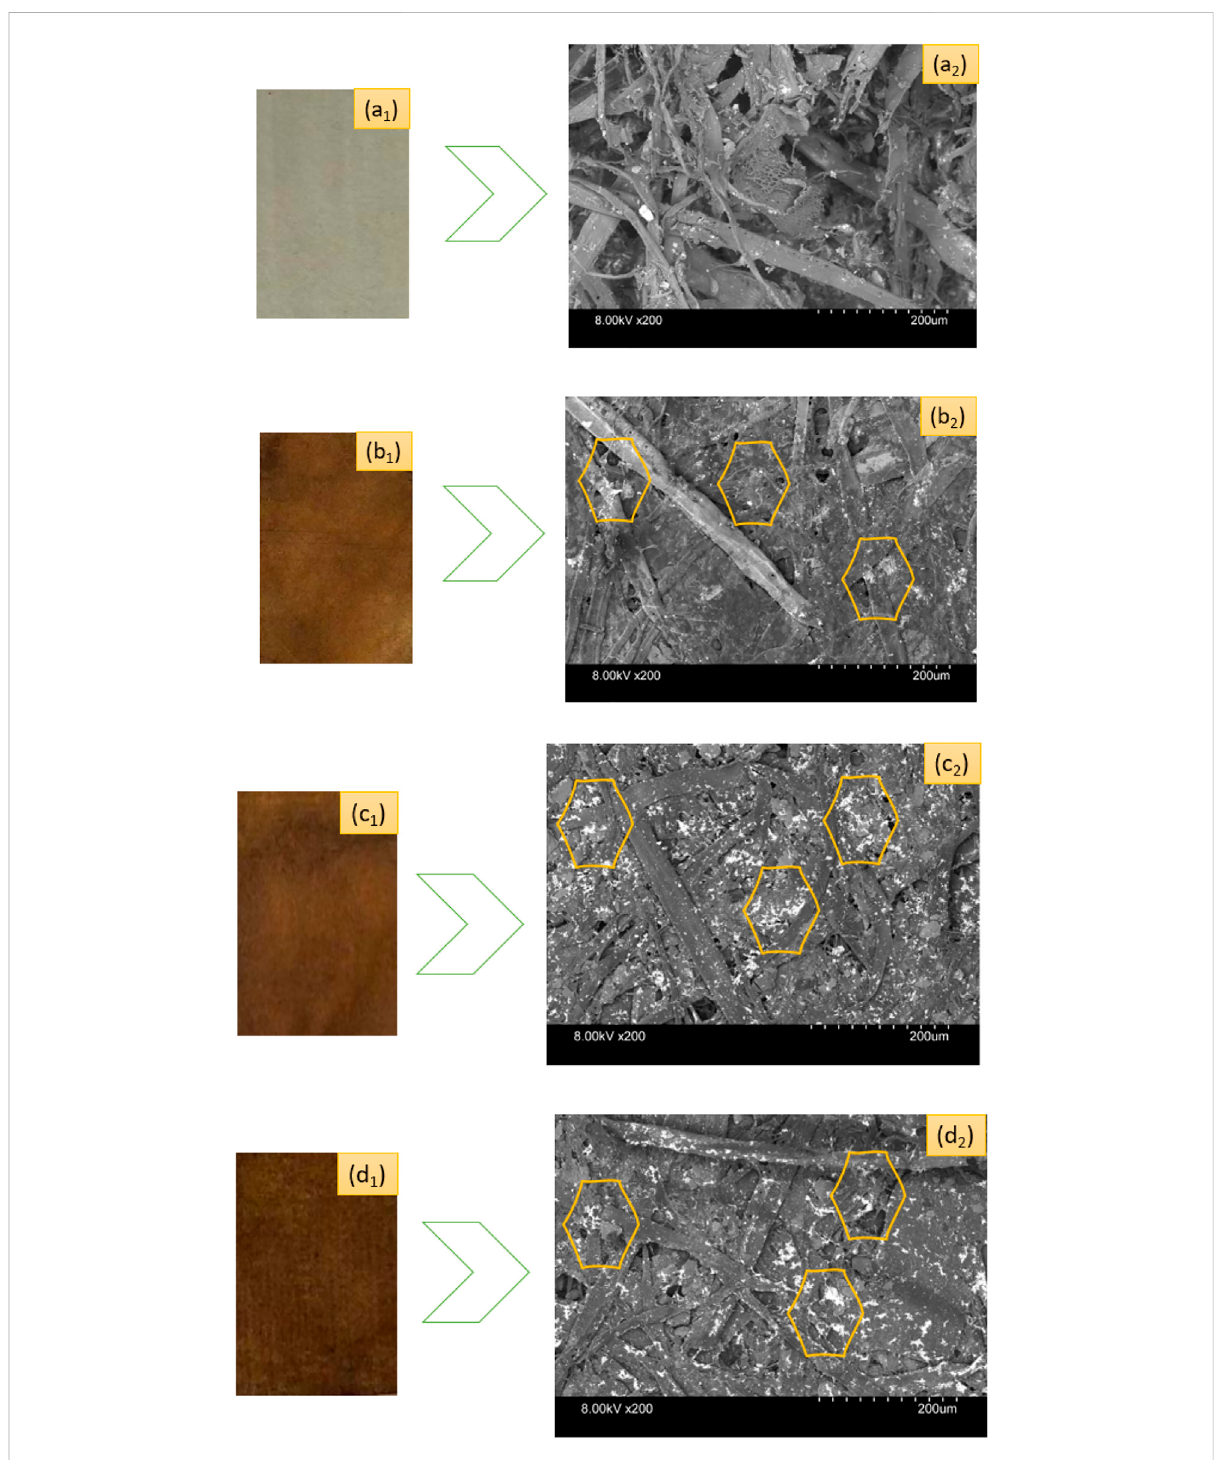
FIGURE 3 Photographsofcontrolandnanosilverdepositedkraftpapersamples: (A 1 ) P@C, (B 1 ) P@Ag1, (C 1 ) P@Ag2,and (D 1 ) P@Ag3.SEMimagesofcontrol and nanosilver deposited kraft paper samples: (A 2 ) P@C, (B 2 ) P@Ag1, (C 2 ) P@Ag2, and (D 2 )